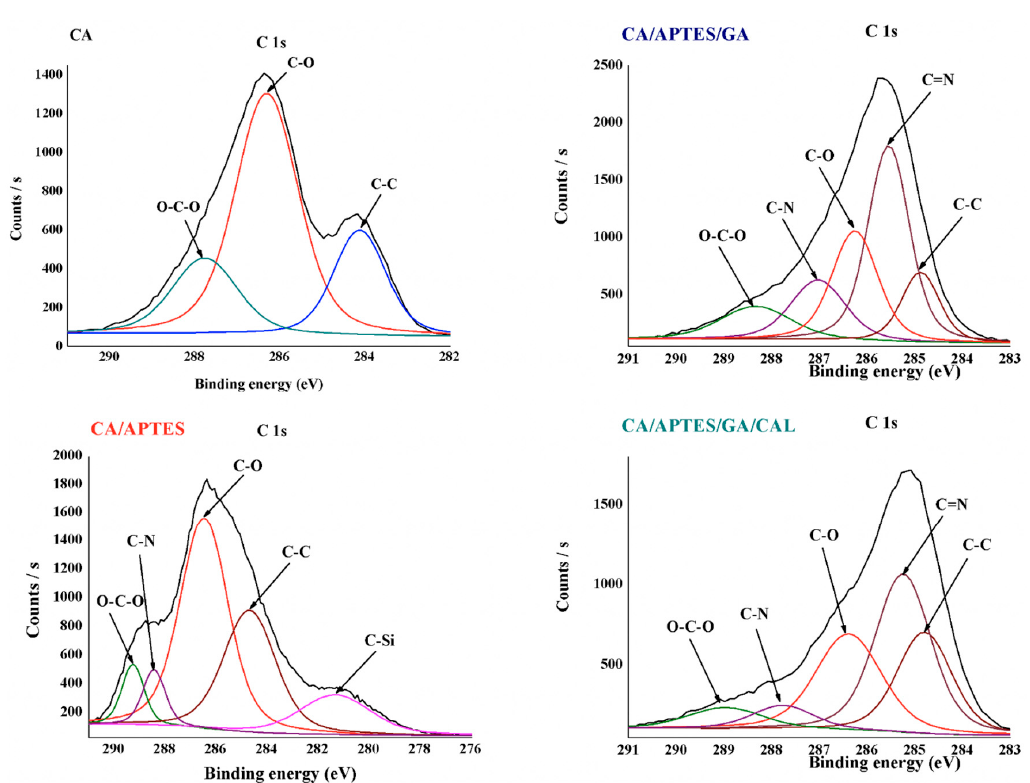
Figure 6. The fitted C 1s spectra for synthesized samples.